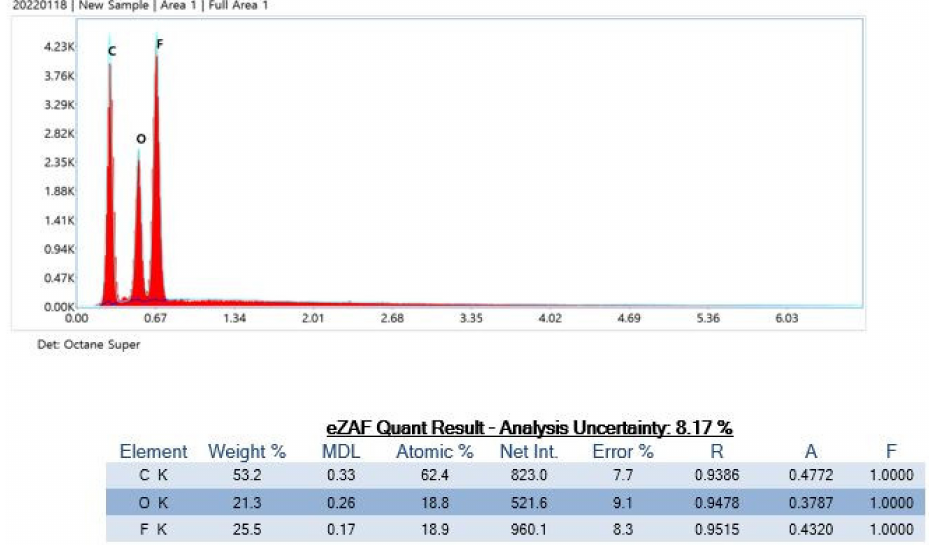
Figure 8. Particle analysis using energy-dispersive X-ray spectrometry.